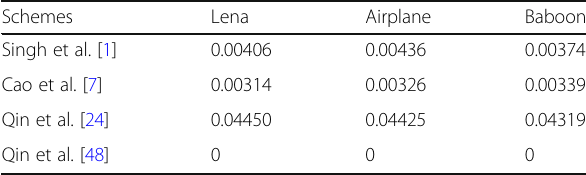
Table 4 Comparisons of tamper detection performance